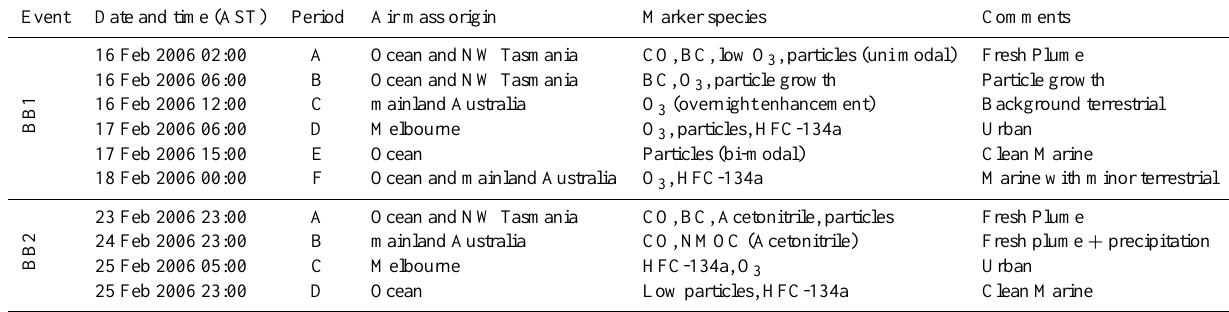
Table 2. Summary of periods described in the text for BB1 and BB2 (as shown in Figs. 3 and 6).